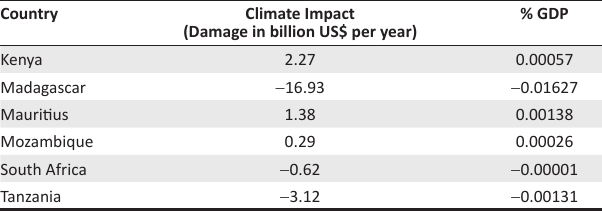
FIGURE 4: Hurricane damage as a fraction of gross domestic TABLE 5: Average impact by country. Country